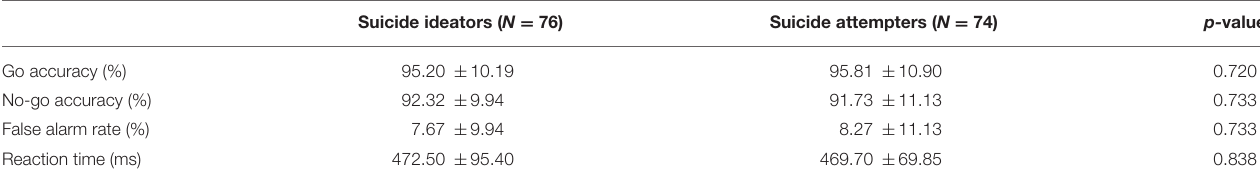
TABLE 2 | Comparison of behavioral outcomes between patients with suicide ideators and with suicide attempters.